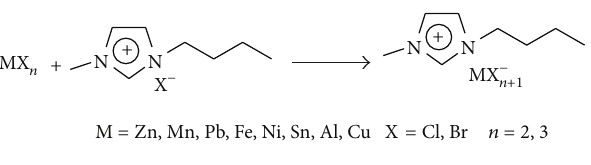
Scheme 1: Synthesis of metal-containing ionic liquids.